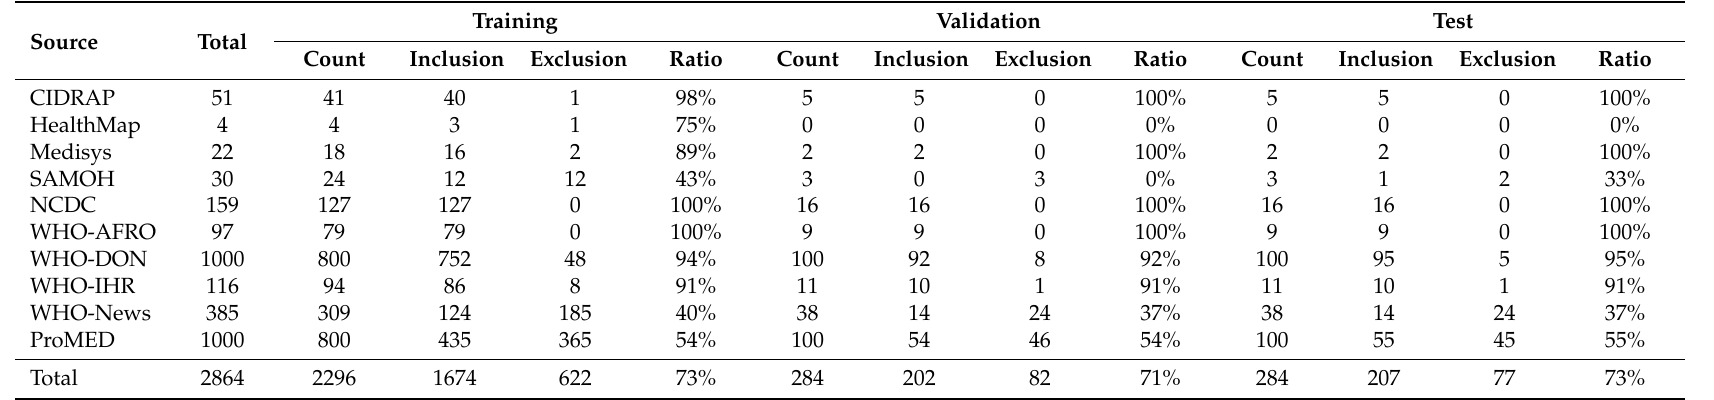
Table 3. Training, validation, and test